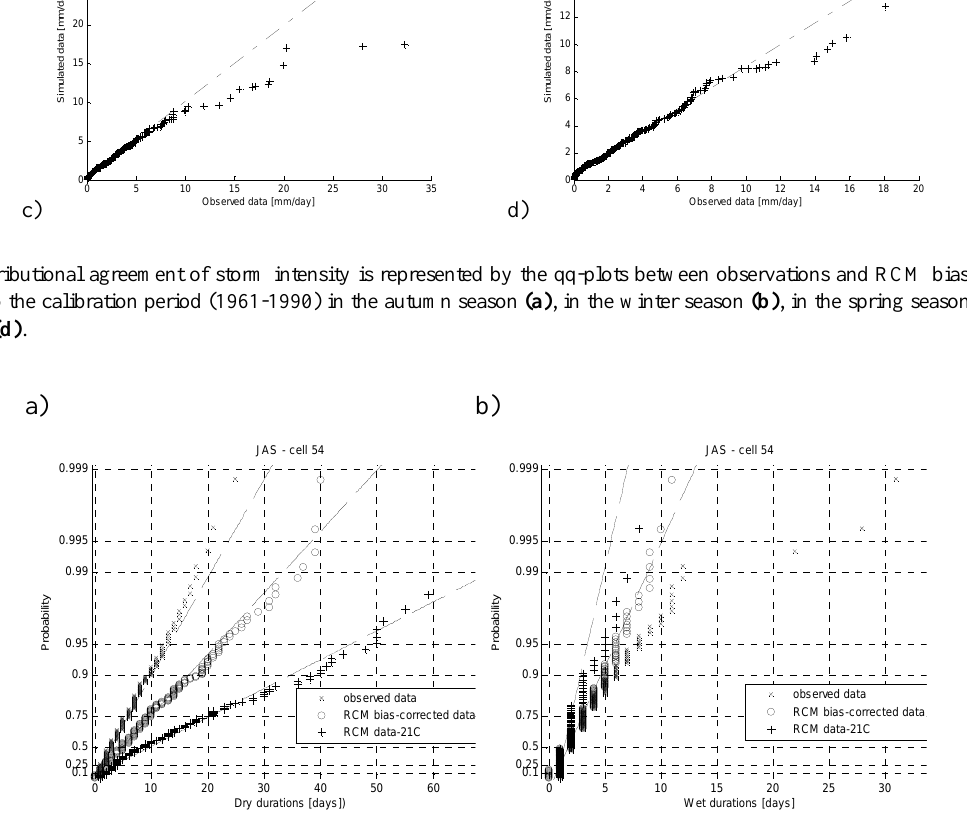
Fig. 7. Exponential probability plots of the dry (a) and wet (b) periods obtained for a grid-cell using the PRP stochastic model in the summer season (marked with circles); with dashed lines the theoretical distributions estimated for the reference observations, the row RCM data, and RCM bias-corrected data for the 21st Century are reported respectively.